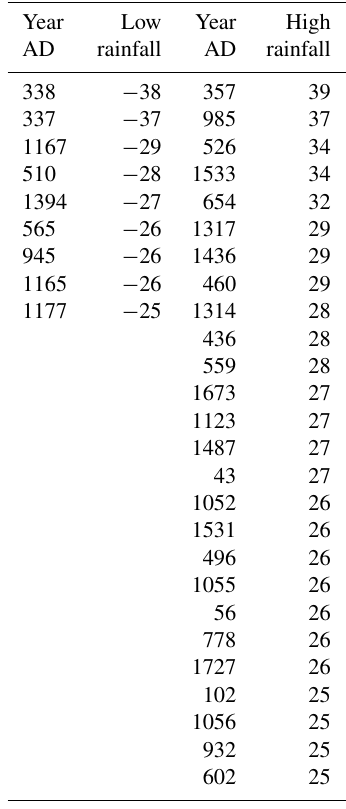
Table 1. List of years with reconstructed far below-/above-average rainfall (26 February–6 July) depicted as deviation (%) from the AD1901–2000 reference